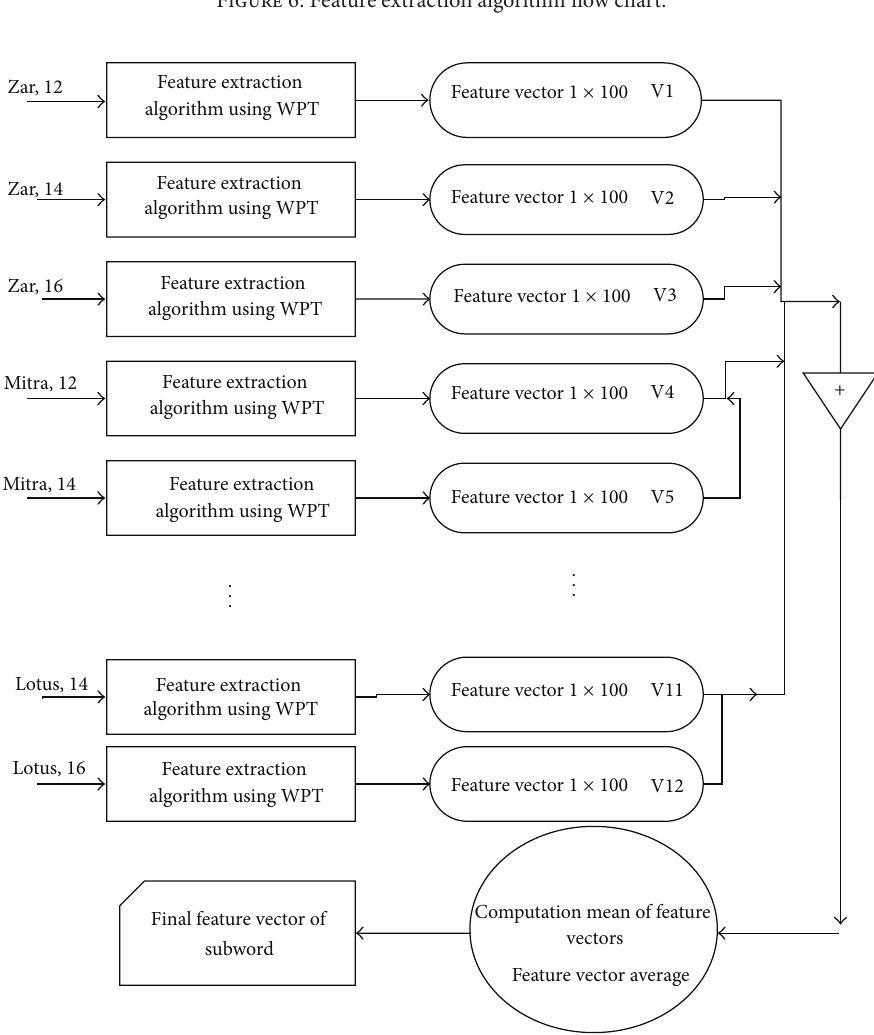
Figure 7: The average computing stage of proposed